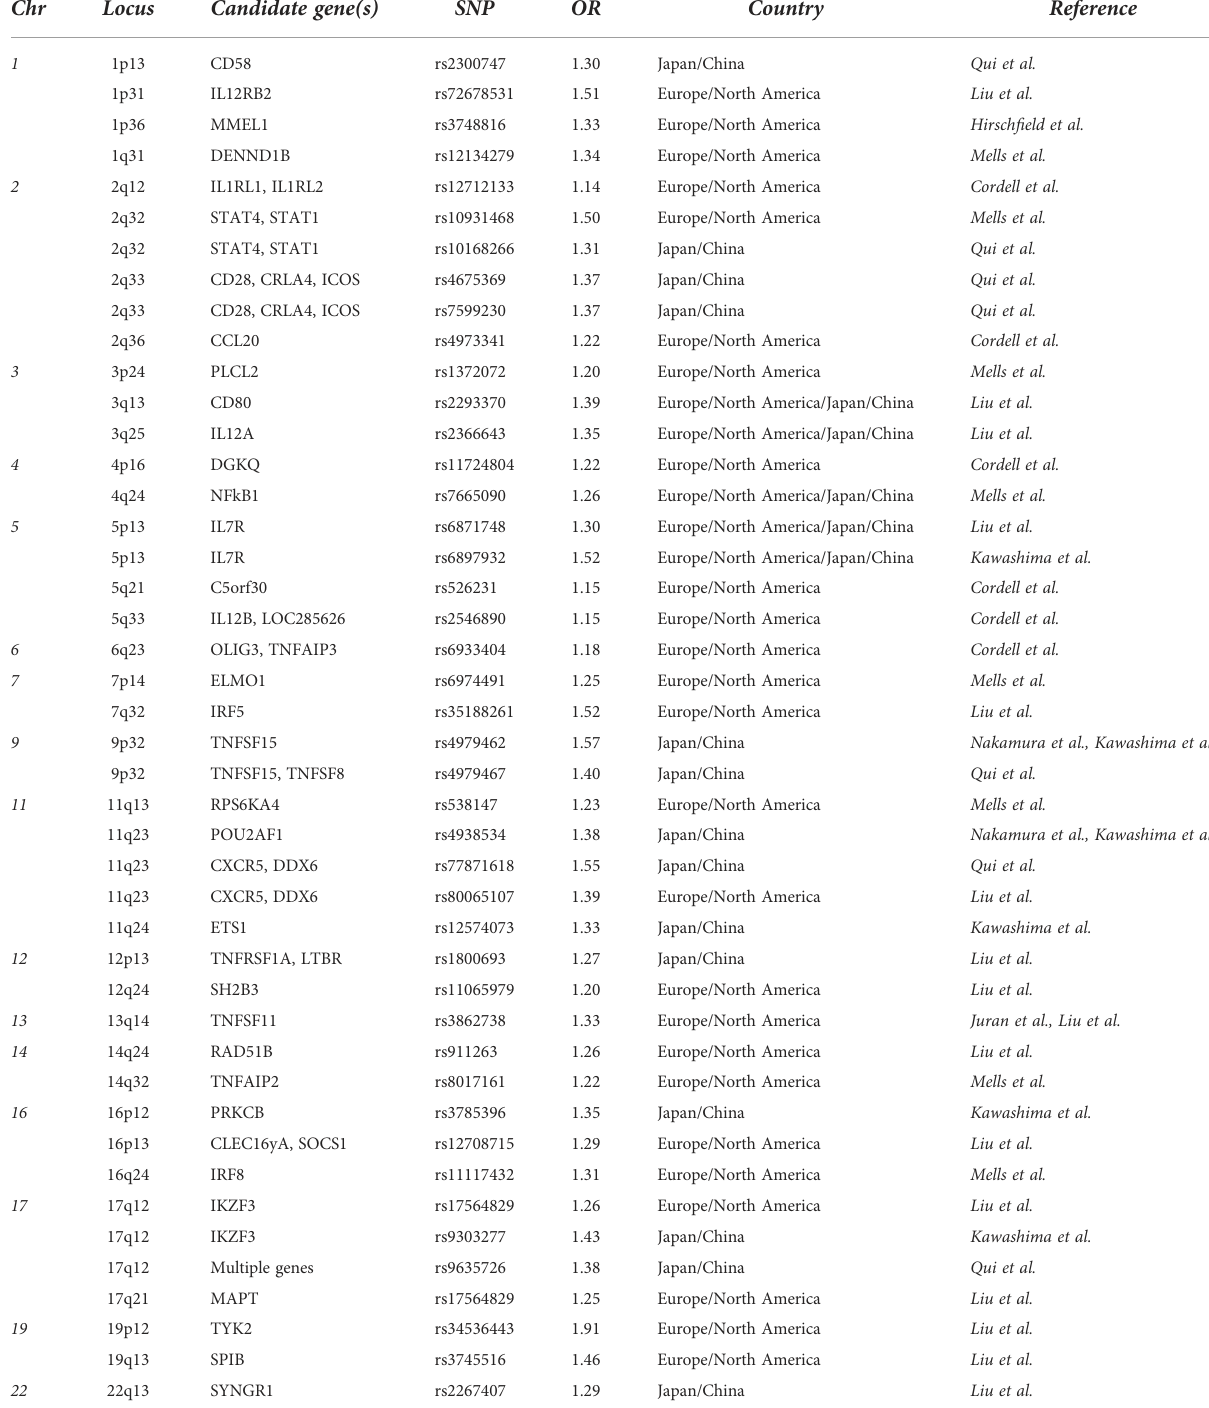
TABLE 1 List of PBC-related non-HLA